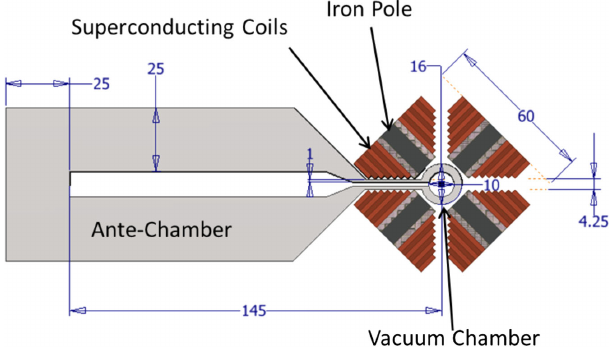
FIG. 5. Preliminary layout shows a cross section of the quadru- pole pole and vacuum chamber for the extraction of synchrotron radiation generated by the poles.